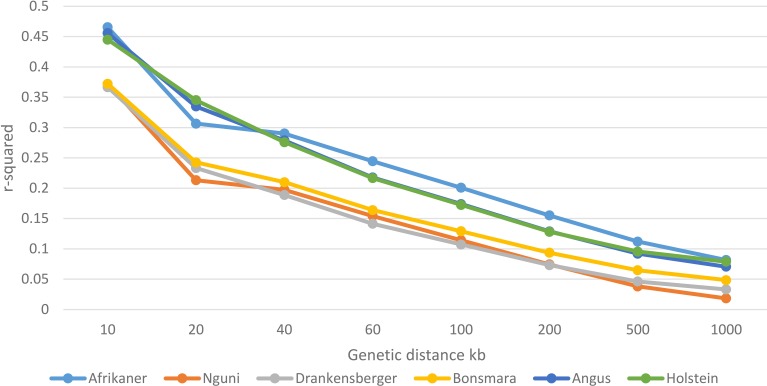
Decay of LD by distance across the studied breeds.